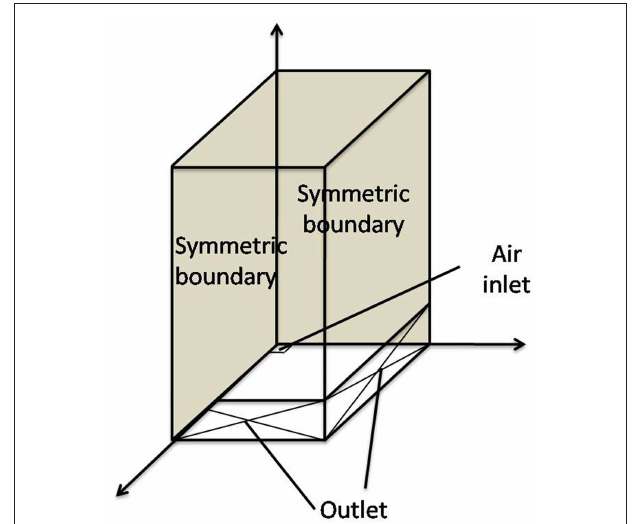
FIGURE 2 | Geometry and boundary